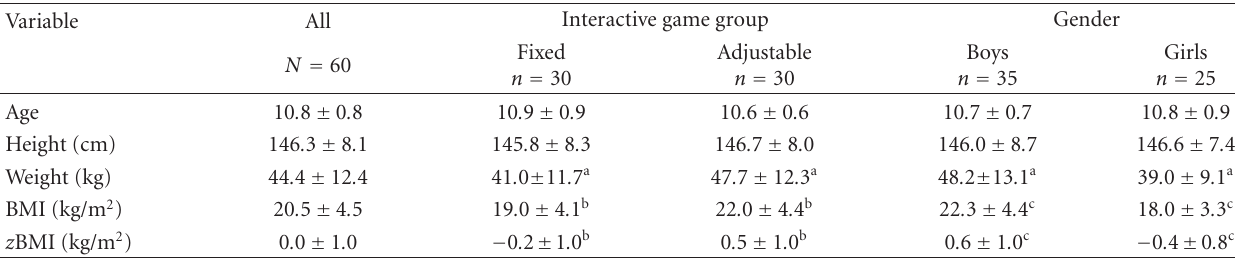
Table 1: Physical characteristics of participants (Mean ± SD).